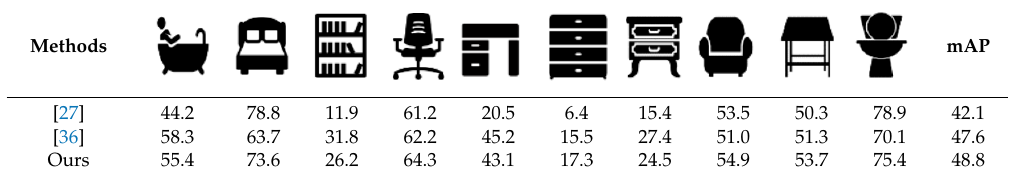
Methods Methods